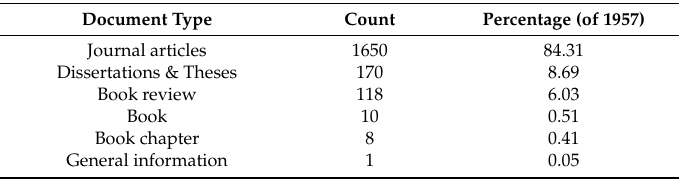
Table 11. Document types for SLW publications in LLBA.